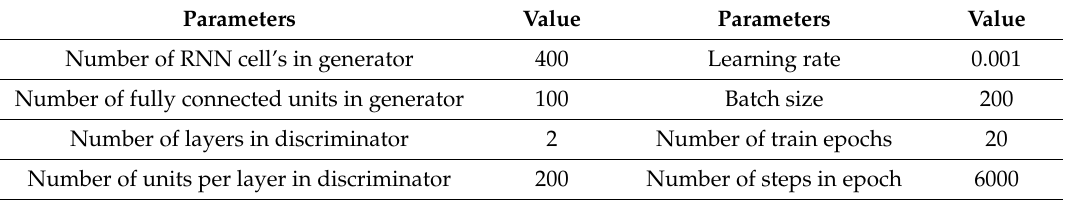
Table 2. Parameters and hyperparameters of the tabular generative adversarial network (TGAN) model. Parameters Value Parameters Value Number of RNN cell’s in generator 400 Learning rate 0.001 Number of fully connected units in generator 100 Batch size 200 Number of layers in discriminator 2 Number of train epochs Number of units per layer in discriminator 200 Number of steps in epoch 6000